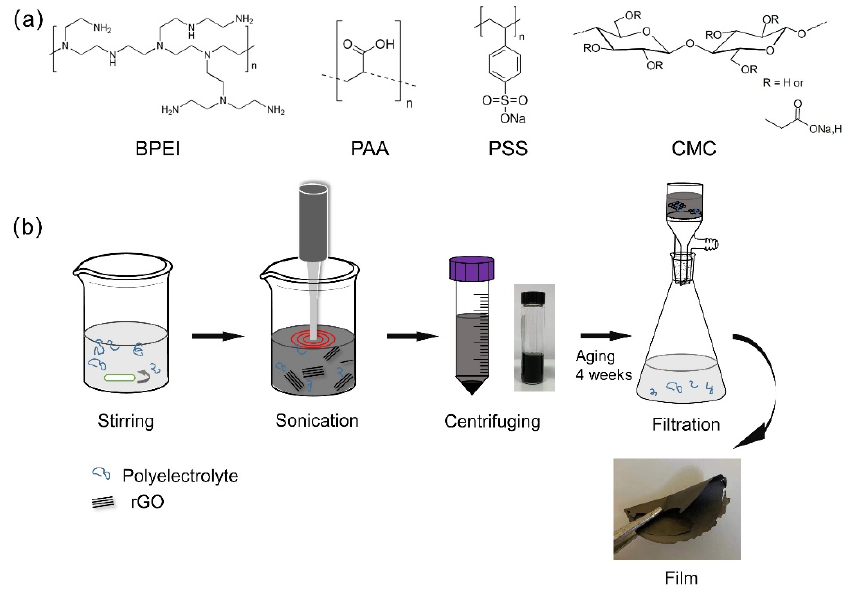
Figure 1. Chemical structure of selected PEs ( a ); illustration of the fabrication process ( b ).